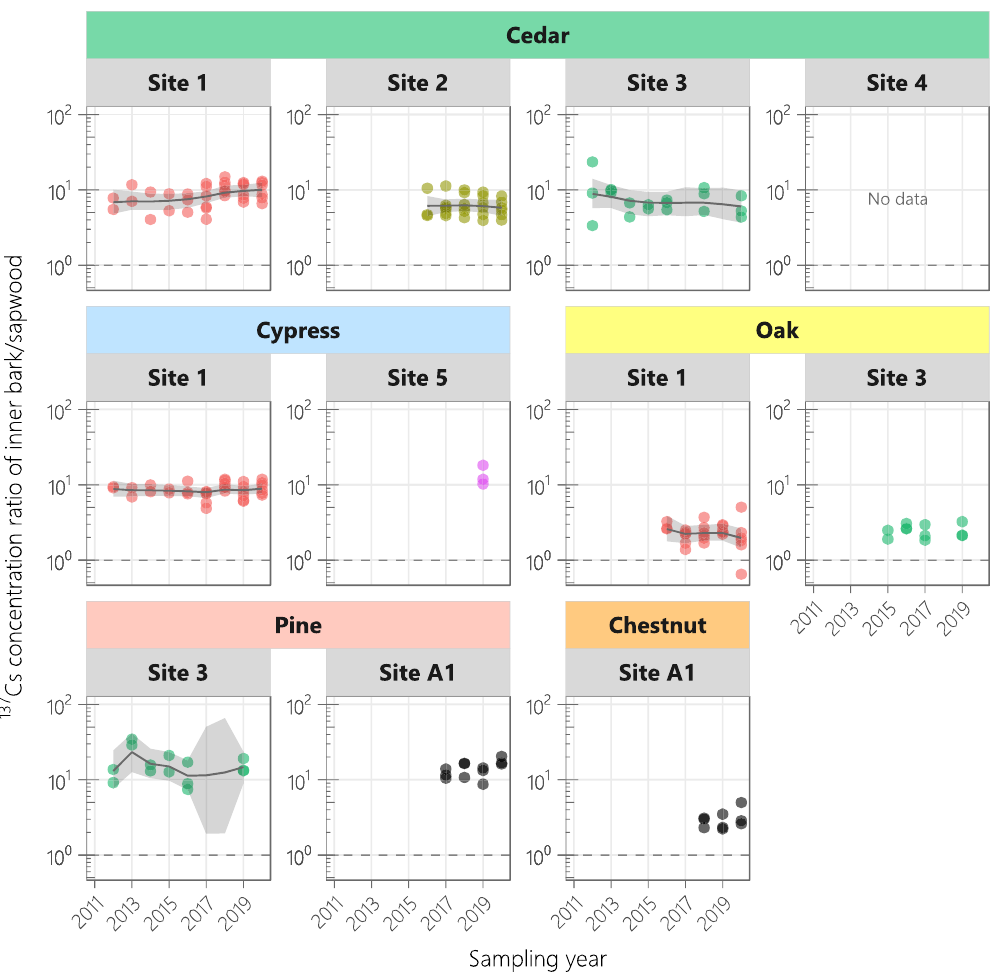
Figure 5. Temporal variations in 137 Cs concentration ratio of inner bark/sapwood. Circles show the observed values. The true states were estimated using a dynamic linear model, and the median values and 95% credible intervals are shown by solid lines and shaded regions , respectively. Sapwood data from 2011 to 2016 were provided in previous studies 8,25